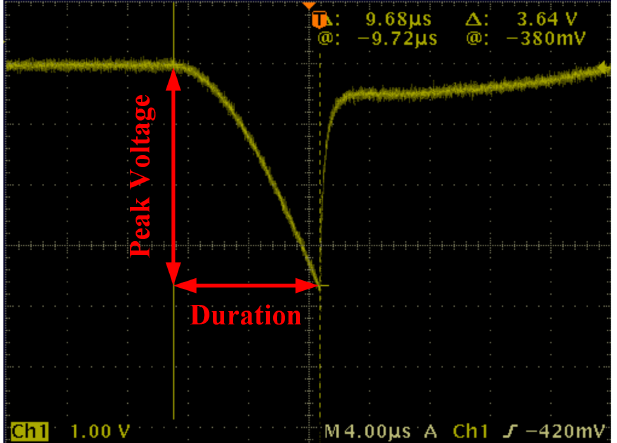
Figure 3. Typical breakdown waveforms obtained by the oscilloscope. The typical voltage-rising duration is approximately 10 µ